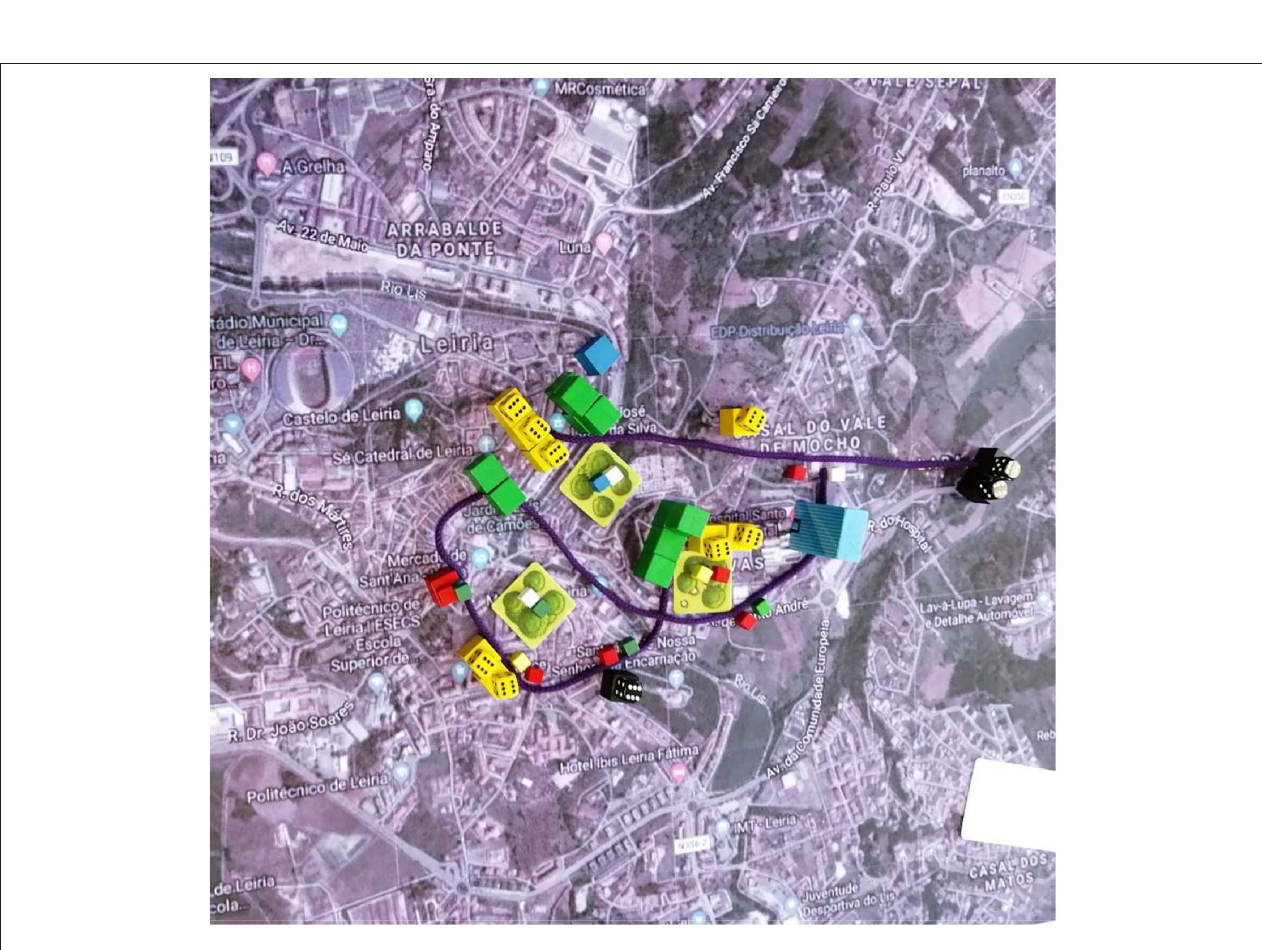
FIGURE 5 | Final visual result from the second game (East View).